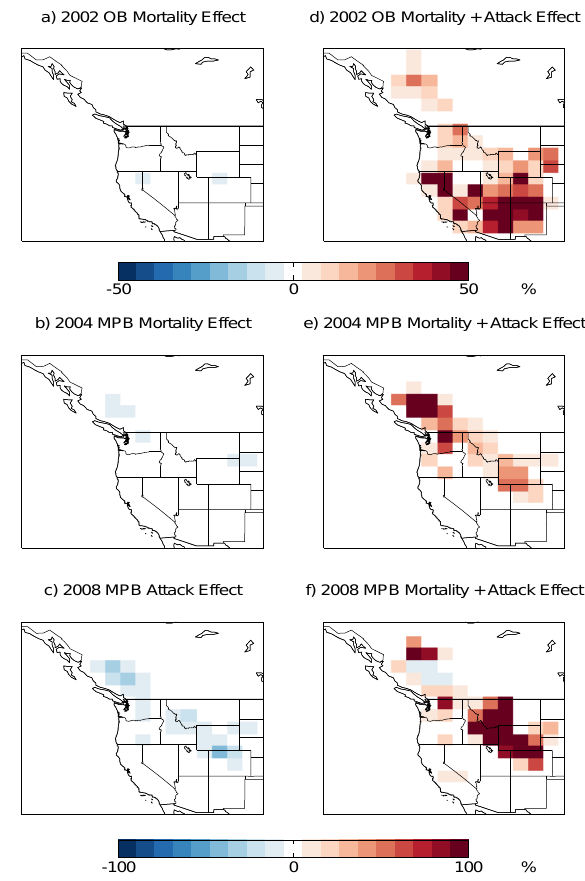
Fig. 4. Change in simulated summer-mean β -phellandrene emis- sions due to other beetle attack in 2002 and mountain pine bee- tle attack in 2004 and 2008 following the pine scenario. Change in emissions due to the mortality effect alone (a–c) and the mortality plus attack effect (d–f) . Color bars are saturated at their respected